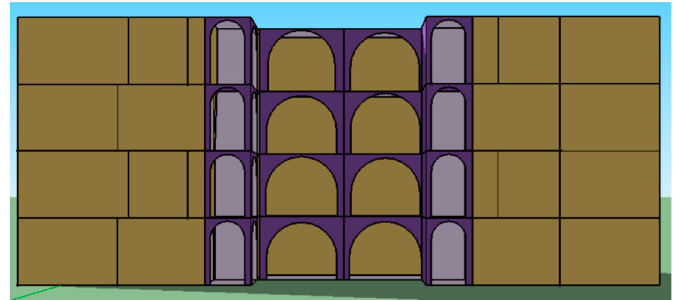
Figure 11. A view of the building corresponding to configuration 4.